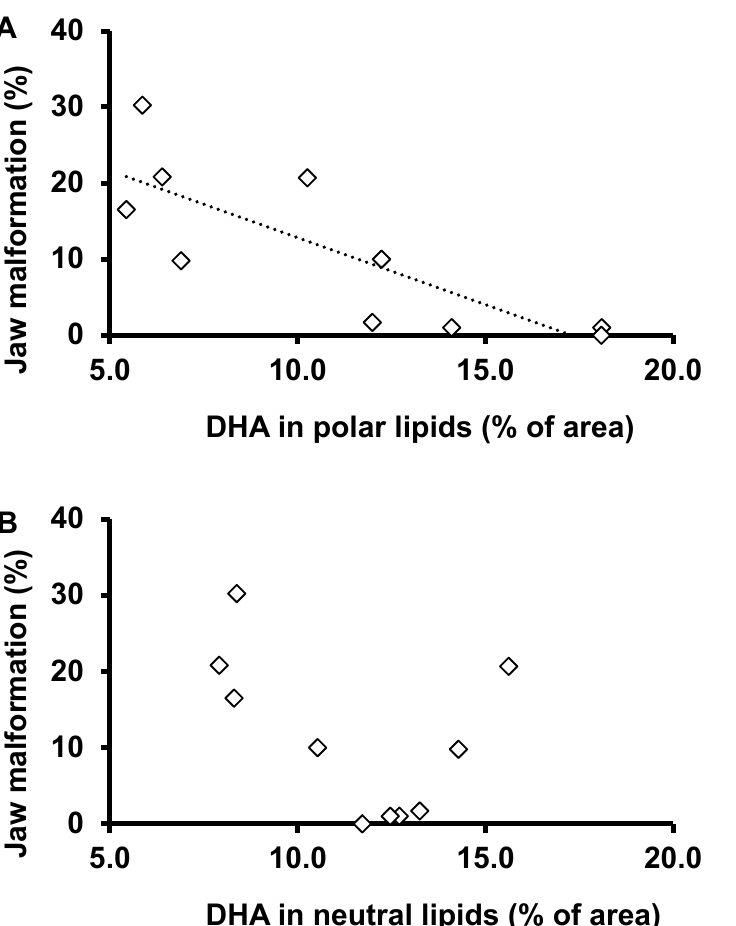
Figure 7. Relationship between the proportion of DHA within polar ( A ) and neutral ( B ) lipids of 40-day-old larvae and the total rate of jaw malformation in cultured Seriola lalandi . The dotted line in figure a represents the linear regression line.